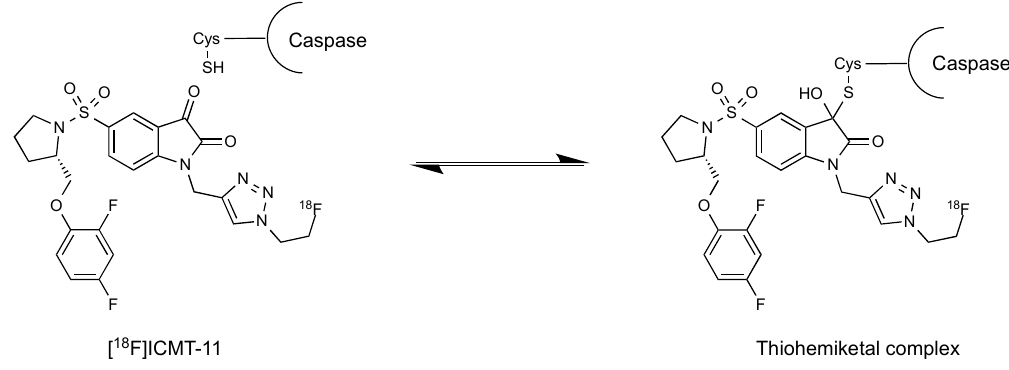
Figure 3. Mechanism of isatin reversible binding to caspases through formation of a thiohemiketal complex.